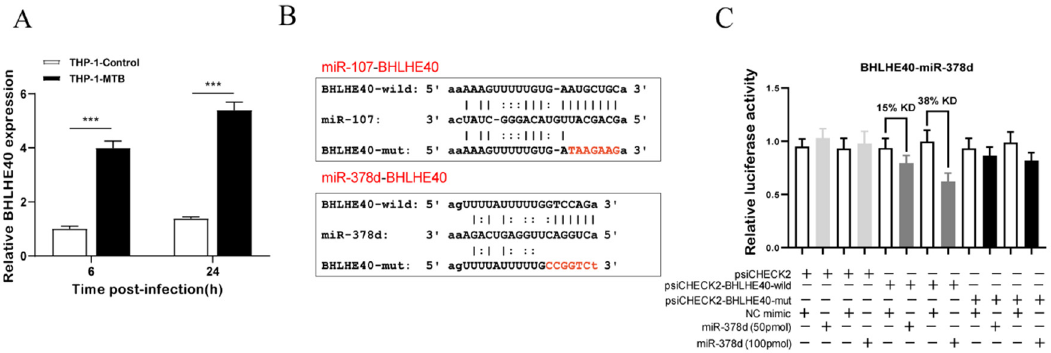
Figure 6. BHLHE40- miR-378d-BHLHE40 regulation axis verification. ( A ) THP-1 cells were infected with MTB-1458 at a MOI of 10 for 12 h. Cells were washed twice and a medium with gentamycin (100 μ g/mL) was added. Thereafter, total RNA was collected at 6 and 24 hpi. BHLHE40 expression level was evaluated by qRT-PCR. ( B ) The binding site of miR-378d with BHLHE40 3 ′ -UTR mRNA or mutant of BHLHE40 3 ′ -UTR mRNA. ( C ) Dual-luciferase reporter assay was executed in 293T cells. The psiCHECK2, psiCHECK2- BHLHE40 -wild, and psiCHECK2- BHLHE40 -mut plasmids were cotransfected with NC mimic or miR-378d mimic. The relative luciferase activity means Renilla to firefly ratio (Rluc/Fluc) in miR-378d mimic or NC mimic. KD represents knockdown. “***” represents p < 0.001, “+” represents presence, “ − ” represents